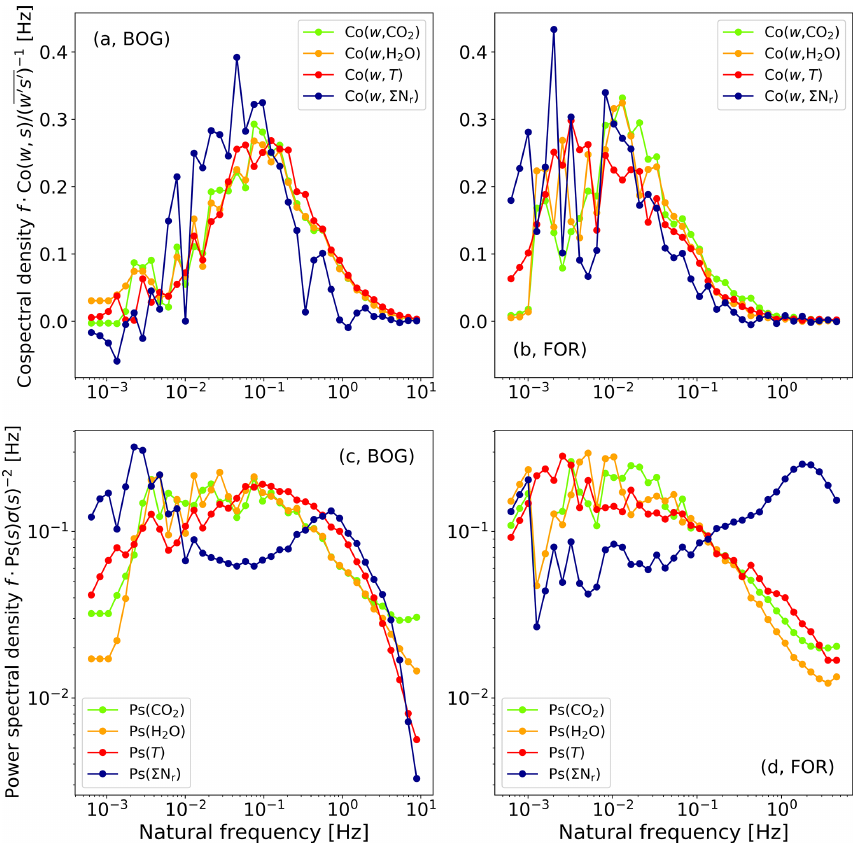
Figure 3. Normalized cospectra and power spectra of T (red), (cid:54) N r (blue), CO 2 (green), and H 2 O (orange) at BOG (a, c) and FOR (b, d) . (Co)spectra were averaged at BOG from 11 October 2012 09:00CET to 11 October 2012 16:30CET ( ζ = − 0 . 31, u = 1 . 36ms − 1 ) and at FOR from 16 October 2016 10:00CET to 16 October 2016 15:30CET ( ζ = − 3 . 27, u = 1 . 89ms − 1 ). CO 2 and H 2 O (co)spectra of BOG were adjusted to the aerodynamic measurement height of the (cid:54) N r setup. Note that the time period used for averaging is different from the periods of Fig.